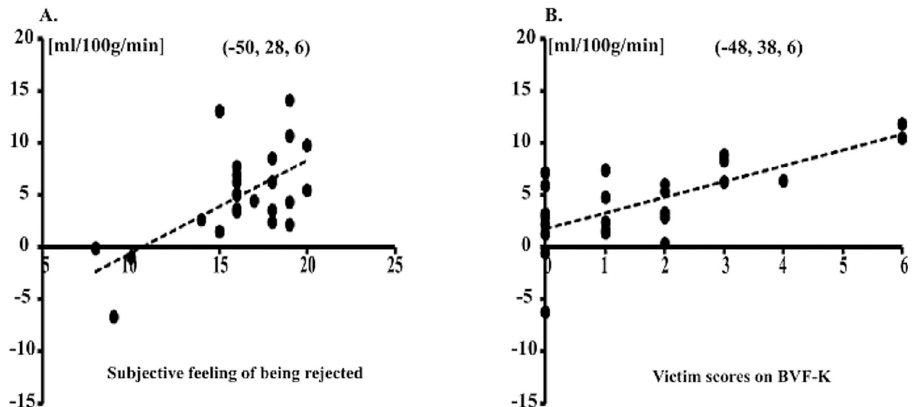
Fig 2. Linear relationships between CBF and subjective feeling of being rejected and between CBF and victim scores. ( A) Positive linear relationship between subjective feeling of being rejected (x-axis) and CBF changes in the contrast of exclusion minus inclusion (y-axis) in left IFG at the peak voxel. Greater change of CBF was significantly associated with higher scores for the subjective feeling of being rejected. (B) Positive linear relationship between victim scores on BFV-K (x-axis) and CBF changes in the contrast of exclusion minus inclusion (y-axis) in left IFG at the peak voxel. Greater change of CBF was significantly associated with higher victim scores.